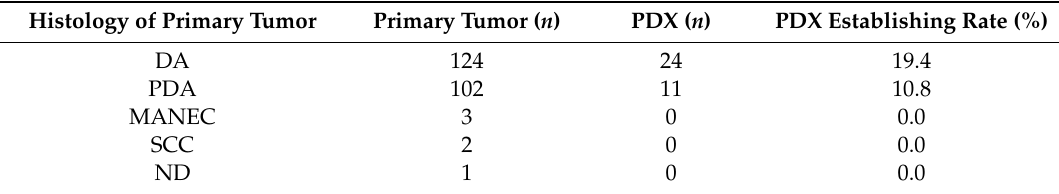
Table 6. Histological subtypes of Primary tumor and PDX.